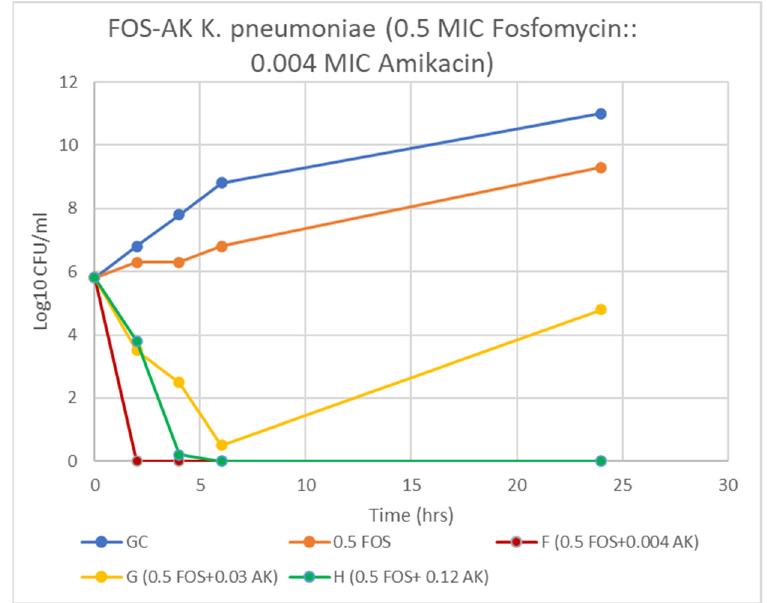
Figure 3. Time-kill curve of K. pneumoniae (Kp 5) at 0.5 MIC fosfomycin alone and combined with 4, 32, and 128 mg/L amikacin. F & H = bactericidal effect and G = a synergy at 24 h incubation. 3.7. Fosfomycin-Tigecycline Combination Outcome by Checkerboard and Time Kill Assay No synergy was observed with FOS-TGC combination across all three MLST clones as seen in Table 5. More than two-thirds of the K. pneumoniae isolates (14/18; 77.8%) showed partial synergistic interactions at ≤ 1/8 MIC FOS + 1 MIC TGC ( ≥ 1 mg/L). Antagonism 2